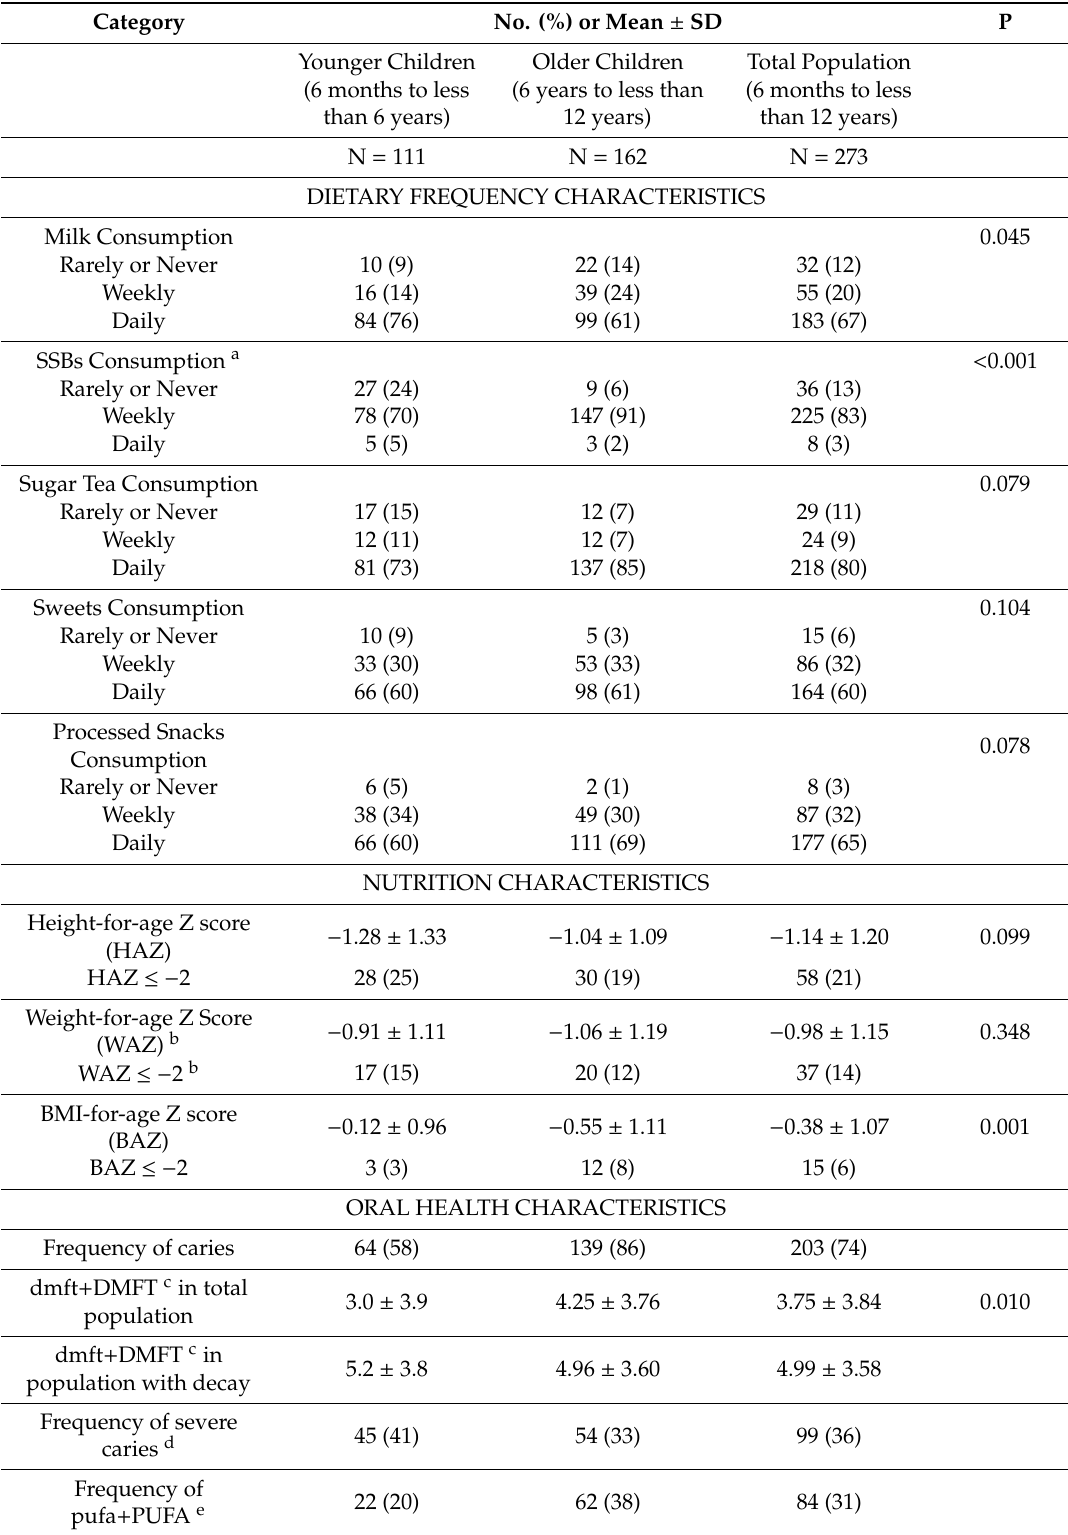
Table 2. Dietary Frequency, Nutrition, and Oral Health Characteristics by